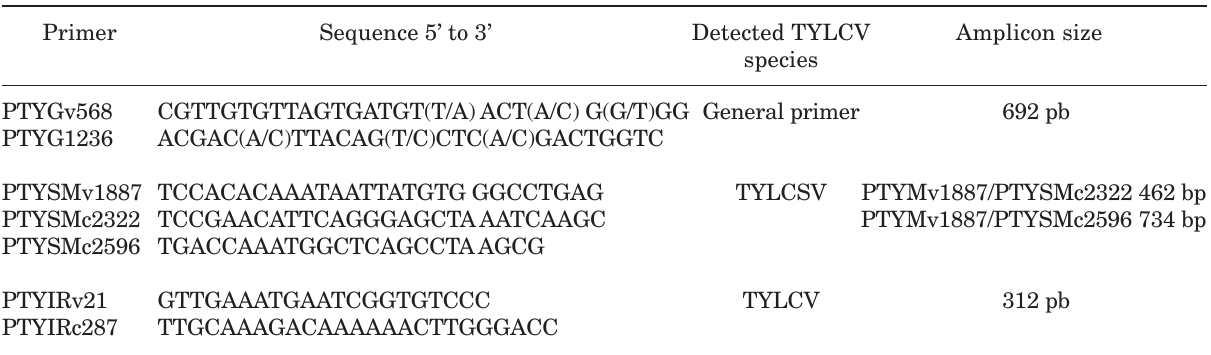
Table 3. Primer sets designed to amplify DNA of TYLCV and TYLCSV from infected tomato plants in Morocco. Primer Sequence 5’ to 3’